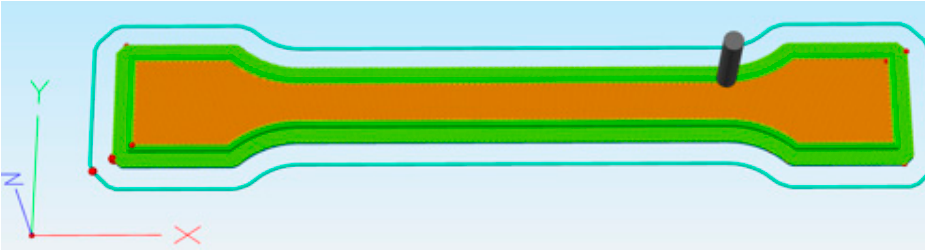
Figure 11. Beginnings of working motion outside the monitored zone.